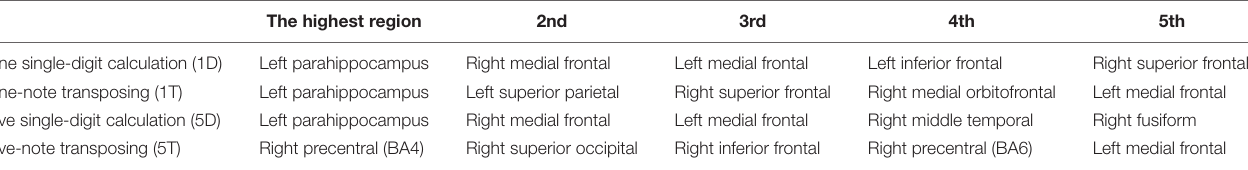
TABLE 2 | Spatial resolution of magnetoencephalography (MEG) signals arising from the top five highest coherent regions during each task. The highest region